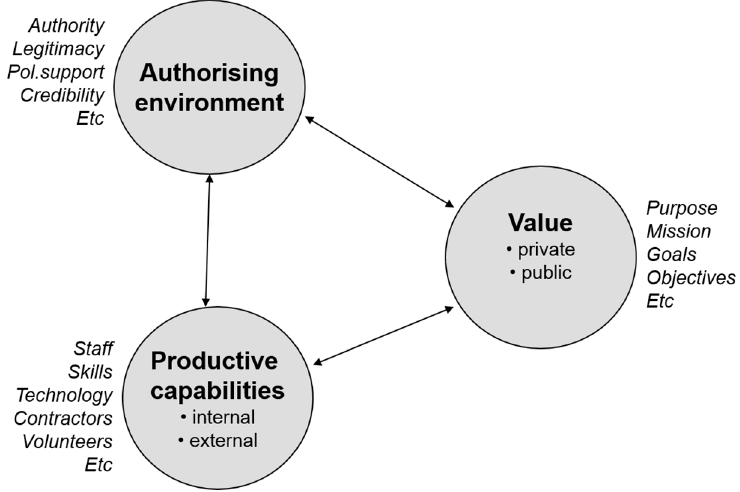
Figure 2. Strategic factors in the public sector.